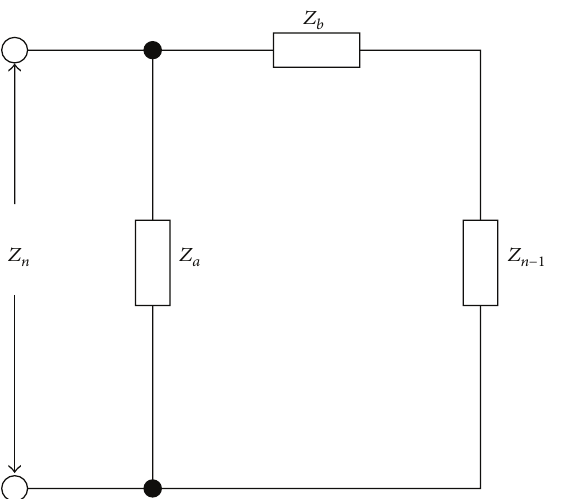
Figure 13: The equivalent circuit of ladder network in Figure